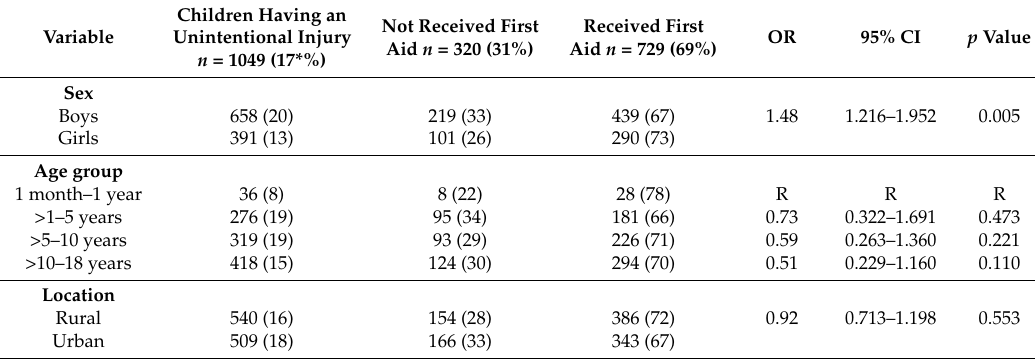
Table 1. Distribution of age, sex and urban and rural location of 1049 children identified with unintentional injuries and those who received first aid.